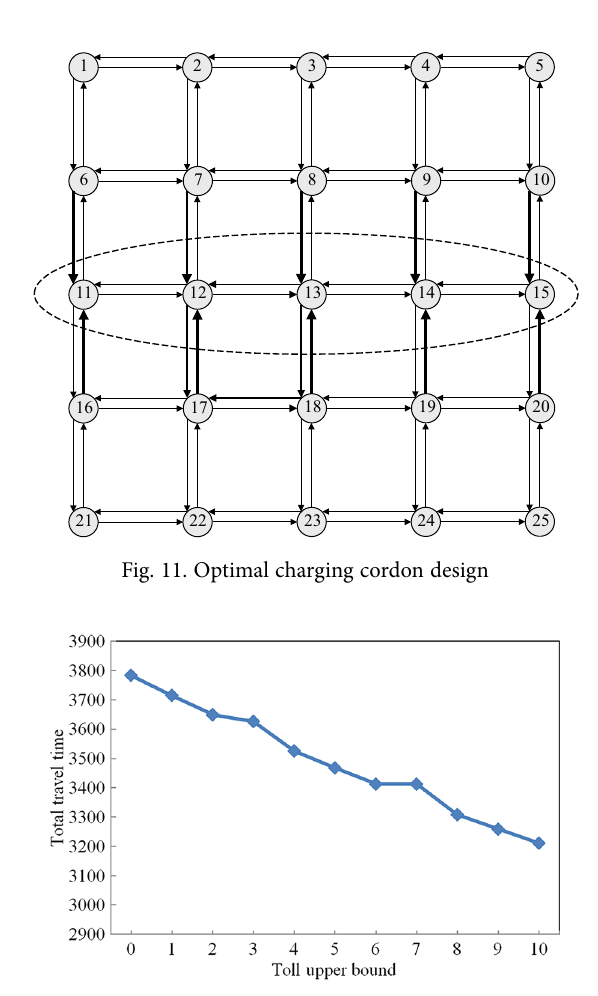
Fig. 12. Optimal objective values with different toll upper bounds under cordon pricing